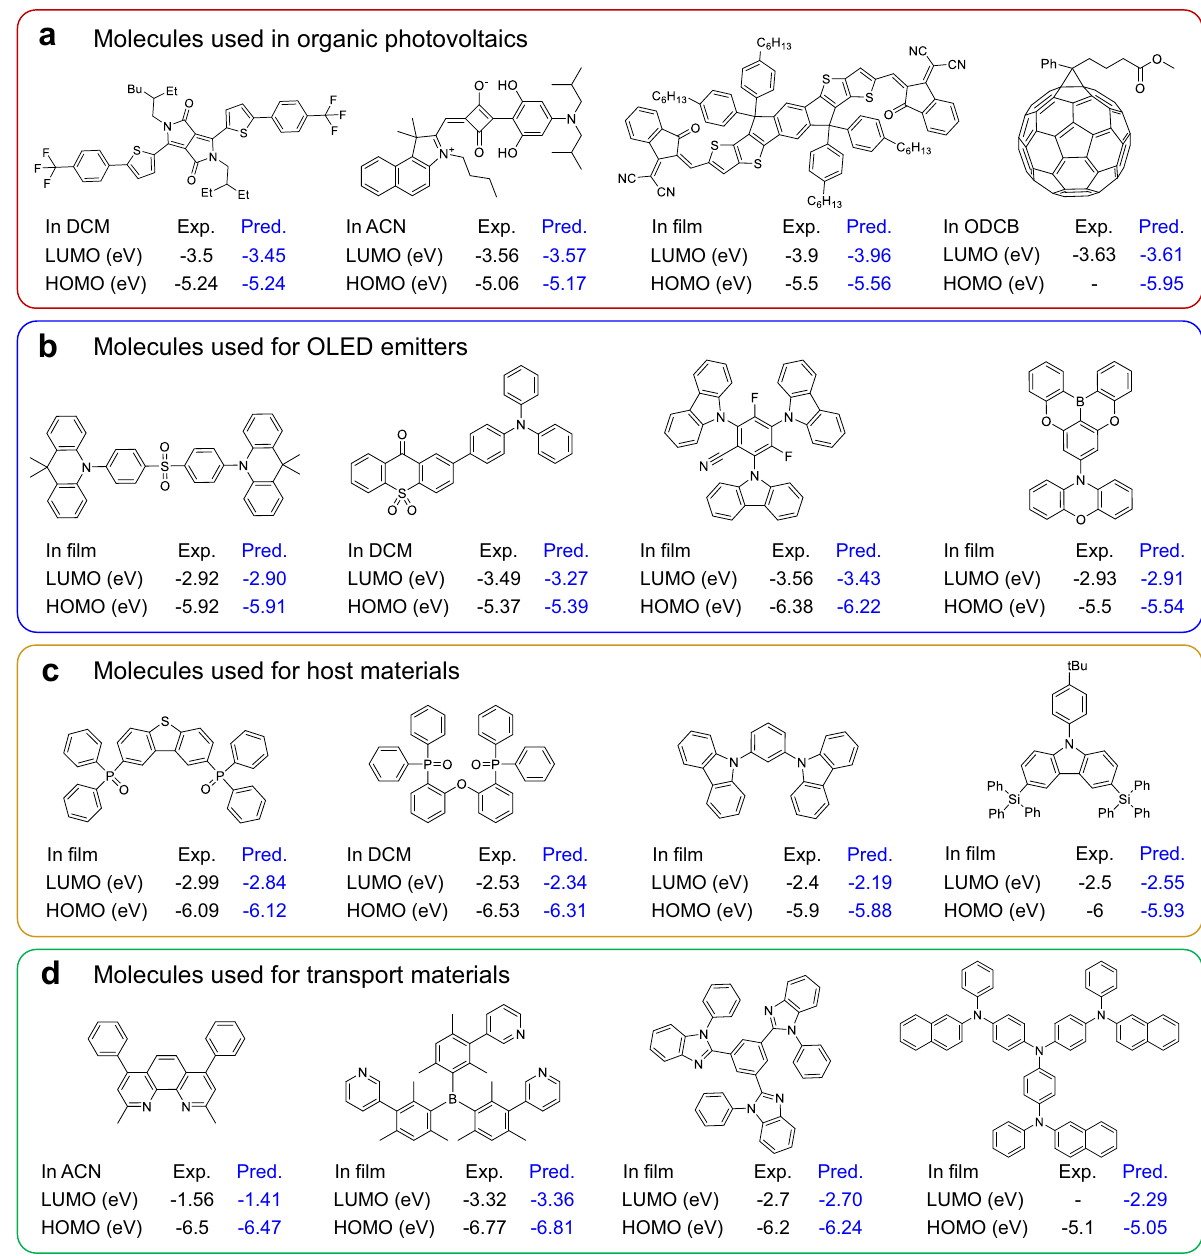
Fig. 3 Experimental and DeepHL-predicted HOMO and LUMO energies for the selected molecules in our experimental database. a Molecules used in organic photovoltaics. b Molecules used for OLED emitters. c Molecules used for host materials. d Molecules used for transport